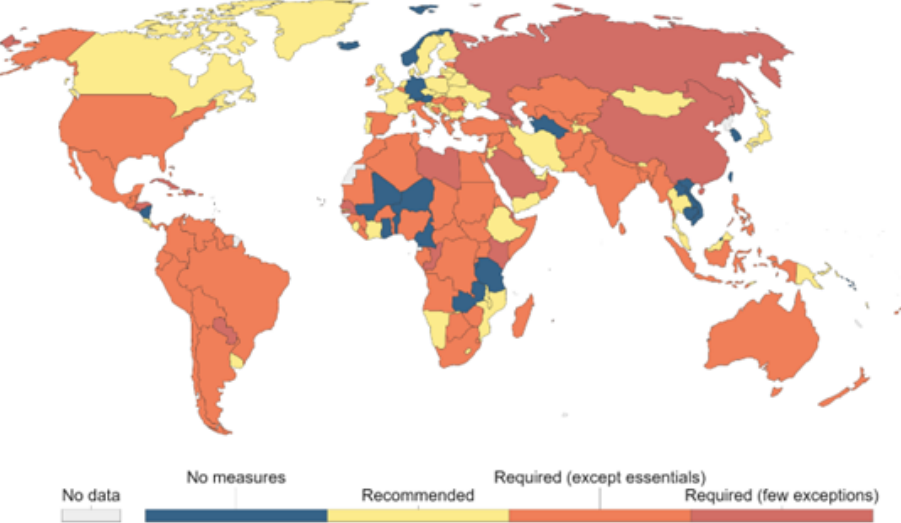
Figure 1. Stay-at-home requirements during COVID-19, 13 May 2020